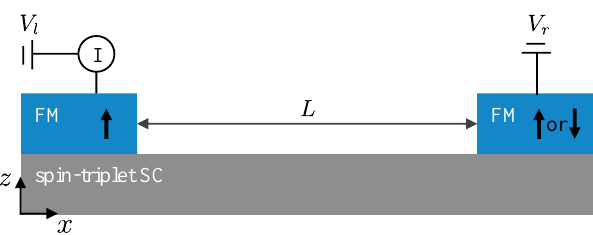
Figure 3: Illustration of an experimental setup for transport experiment, where a spin-triplet superconductor (SC) is used as a charge- and spin-transport medium and two ferromagnetic metals (FMs) serve as magnetic leads with distance L